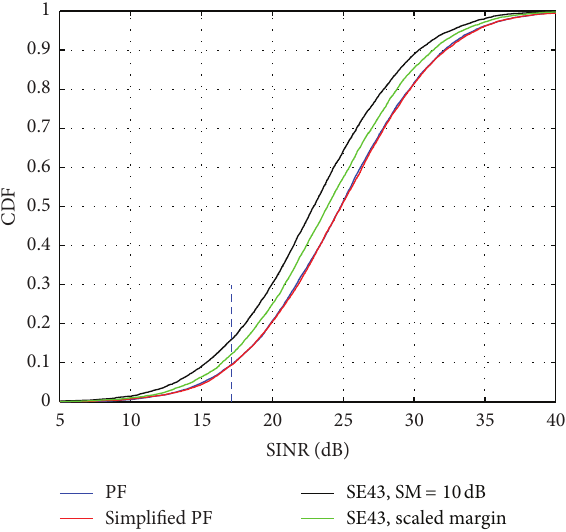
Figure 5: TV SINR distribution at the dominating test point experiencing the highest secondary interference level by using different power allocation rules and protection distance 10 km.